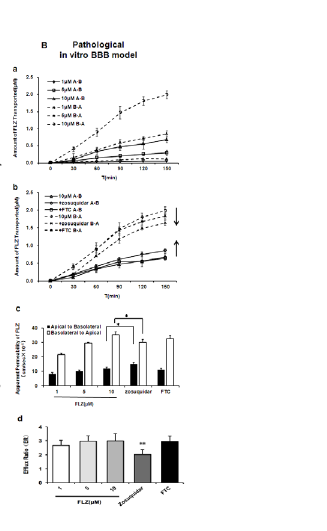
Figure 6. Directional transport of FLZ across physiological (A) and PD pathological (B) BBB models. Transport was measured in the absence or presence of P-gp inhibitor zosuquidar or BCRP inhibitor FTC with time up to 2.5 h. The apical-to-basolateral (A–B) and basolateral-to-apical (B–A) transepithelial flux of various concentrations of FLZ (1, 5, 10 m M) was assessed in physiological (Aa) and pathological (Ba) BBB models, respectively. Papp B–A transport was significantly higher than those for A–B transport at each FLZ concentration (Ac and Bc), indicating the presence of an efflux pump to remove FLZ from within cell membranes. Higher efflux ratio and lower BBB penetration of FLZ were showed under pathology model (Ad and Bd). To examine the contribution of P-gp and BCRP to FLZ transport, permeability of FLZ at initial concentrations of 10 m M in the absence and presence of 5 m M zosuquidar to block P-gp or 10 m M FTC to inhibit BCRP (Ab and Bb) were measured. Only the P-gp inhibitor zosuquidar effectively inhibited efflux of FLZ across the two BBB models, and the black arrows indicate the direction of change in FLZ transport caused by addition of zosuquidar (Ac and Bc). The magnitude of P-gp or BCRP-mediated efflux was estimated by the efflux ratio (ER), defined as the ratio of Papp B–A to the Papp A–B. Upon specific blocking of P-gp using zosuquidar resulted in significantly lower efflux ratio of FLZ in either physiological (Ad) or pathological (Bd) BBB models. However, the efflux ratio between BCRP inhibitor and inhibitor-free group were not significantly different (Ad and Bd). All data are expressed as the means 6 SD (n=3). * P , 0.05 , significantly different from each corresponding control.